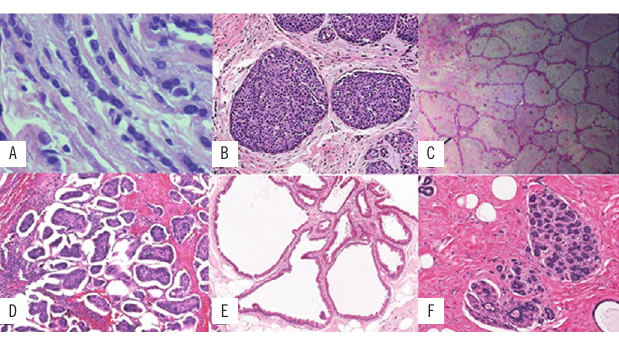
figura 1 – Modelo de imagem usada para desenvolvimento da base de dados do